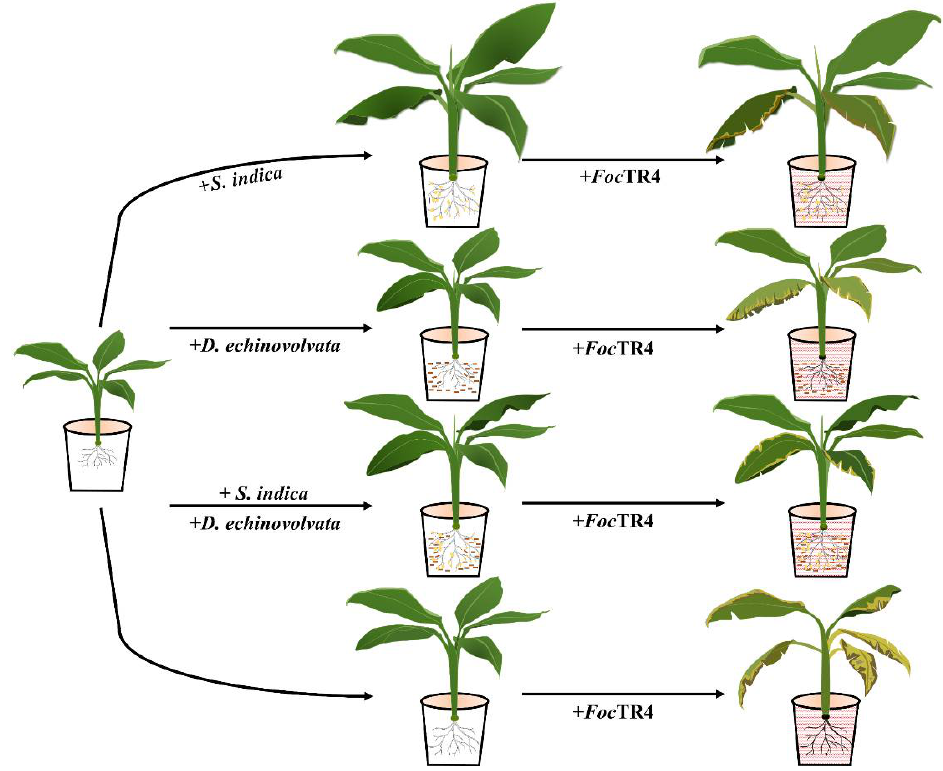
Figure 10. Schematic representation of the influences of Serendipita indica and Dictyophorae echinovolvata on the growth and Fusarium wilt disease resistance of banana. S. indica colonization (displayed in yellow) significantly enhanced the growth of banana, while banana seedlings grown in nutrient soil containing D. echinovolvata culture substrates (displayed in brown) showed suppressed growth. Moreover, both S. indica colonization and D . echinovolvata culture substrates addition alleviated the disease symptoms caused by Fusarium oxysporum f. sp. cubense tropical race 4 ( Foc TR4, displayed in red), and their combined application showed the best effect.